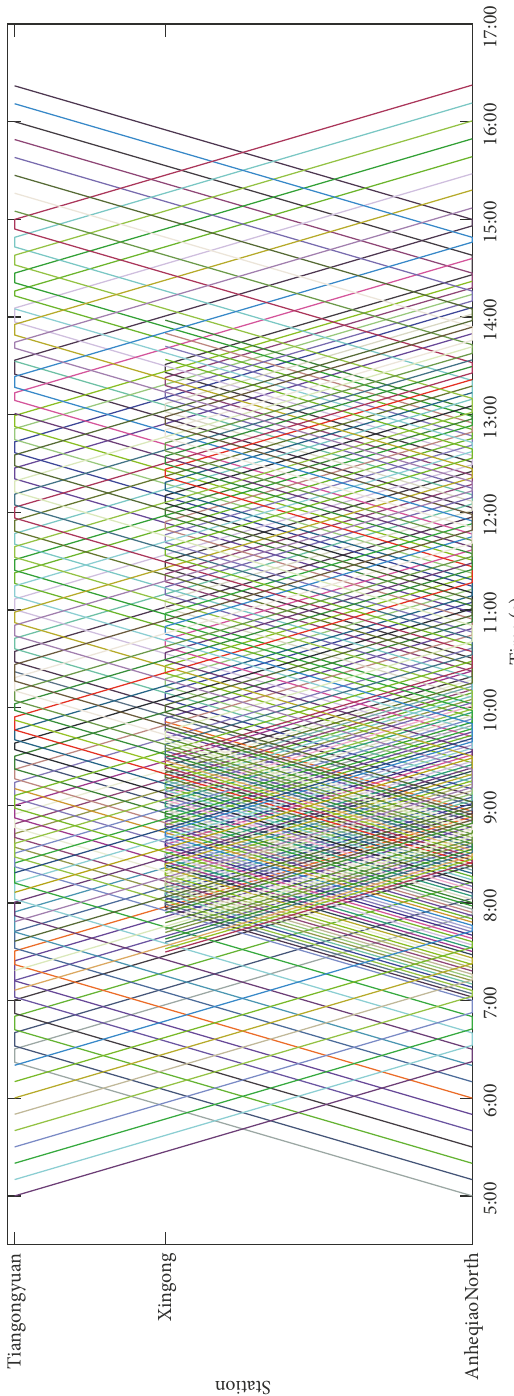
Figure 11: Optimal train schedule with short turning strategy for case